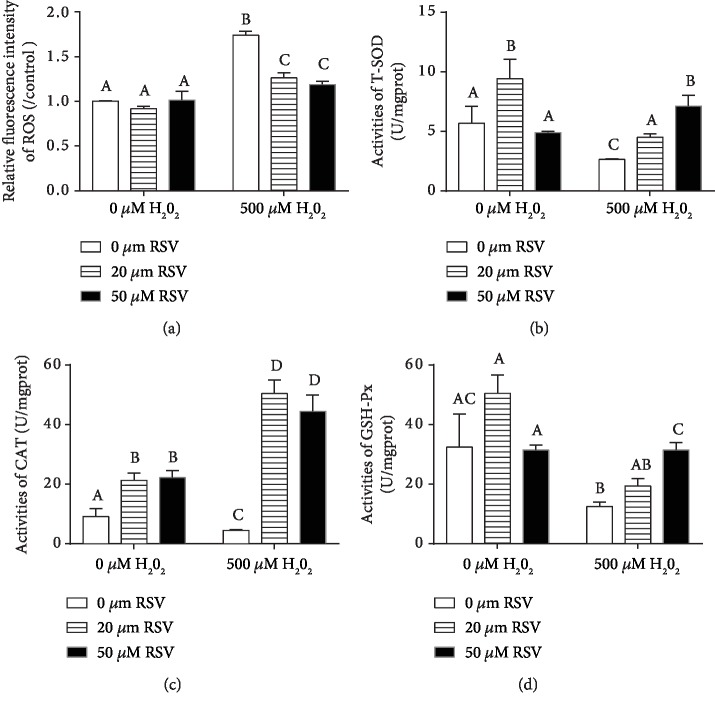
Effects of resveratrol and/or H2O2 on ROS levels and the activities of T-SOD, CAT, and GSH-Px in IPEC-J2 cells. IPEC-J2 cells were pretreated with RSV at the concentration of 0 μM, 20 μM, and 50 μM for 6 hours and then cocultured with 500 μM H2O2 for 4 hours. (a) The fluorescence intensity of ROS was measured by a fluorescence microplate reader. (b–d) Cells were pretreated with or without RSV at the indicated concentrations for 6 h and then incubated in the presence of H2O2 at the concentration of 500 μM, and the activities of T-SOD (b), CAT (c), and GSH-Px (d) in cell lysates were detected by a spectrophotometer using commercial kits. Values are the mean ± SE; n = 6. The columns with the same superscript capital letters and with different superscript capital letters mean no significant difference (P > 0.05) and significant difference (P < 0.05), respectively.